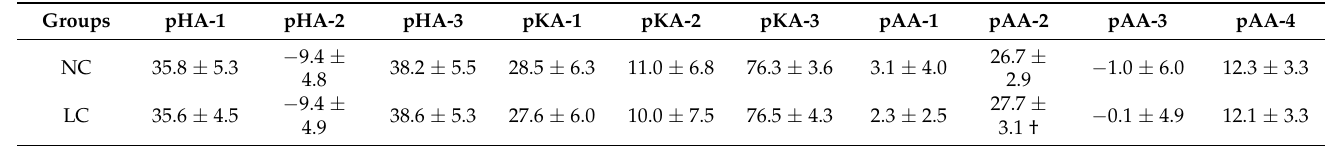
Table 4. Peak joint angle parameters in both groups.